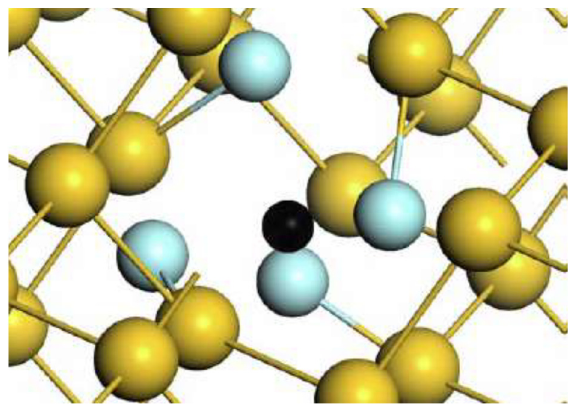
Figure 4. The F 4 V cluster in Ge. The black circle represents the vacancy, the light blue circles F atoms and the yellow circles Ge atoms.